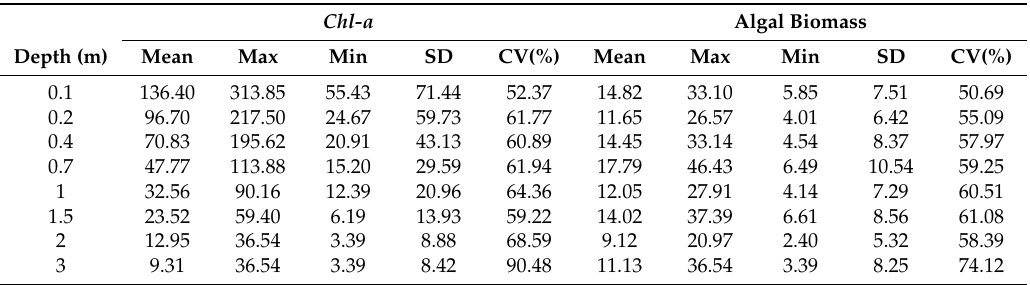
Table 1. Measurements from sampling campaigns in Lake Chaohu from during May, July and October 2013, May 2015 and November 2017: chlorophyll concentration ( Chl-a, μg/L ), algal biomass (mg · m − 2 ) at each different water depth.